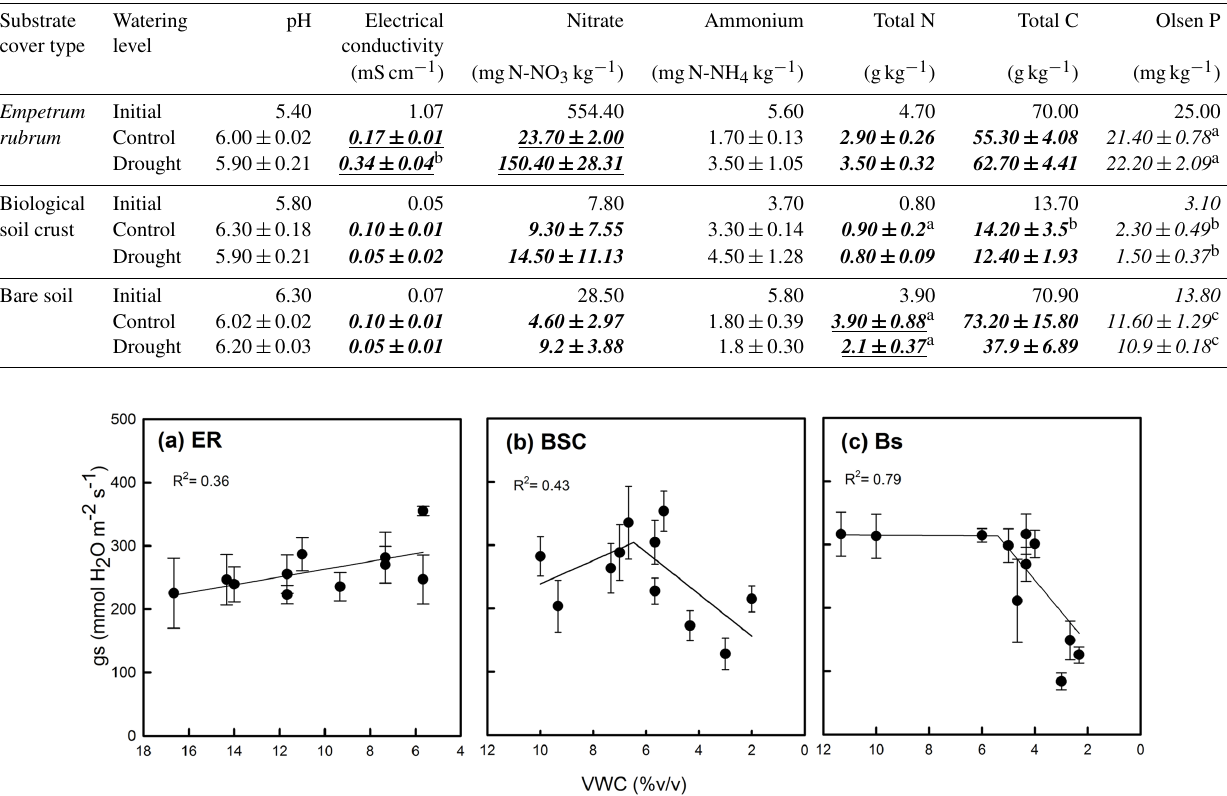
Figure 3. Relationship between volumetric water content (VWC) of soil and stomatal conductance (gs) of Nothofagus pumilio seedlings grown in different treatments of soil cover under conditions of restricted watering. ER, soil covered by Empetrum rubrum ; BSC, soil covered by biological soil crust; and Bs, bare soil. Note the different range of the x axis for panel (a) . Values are the average per measuring date, and fitted regressions are linear or piecewise linear. Statistical analyses of the influence of soil VWC on seedling gs are detailed in Table